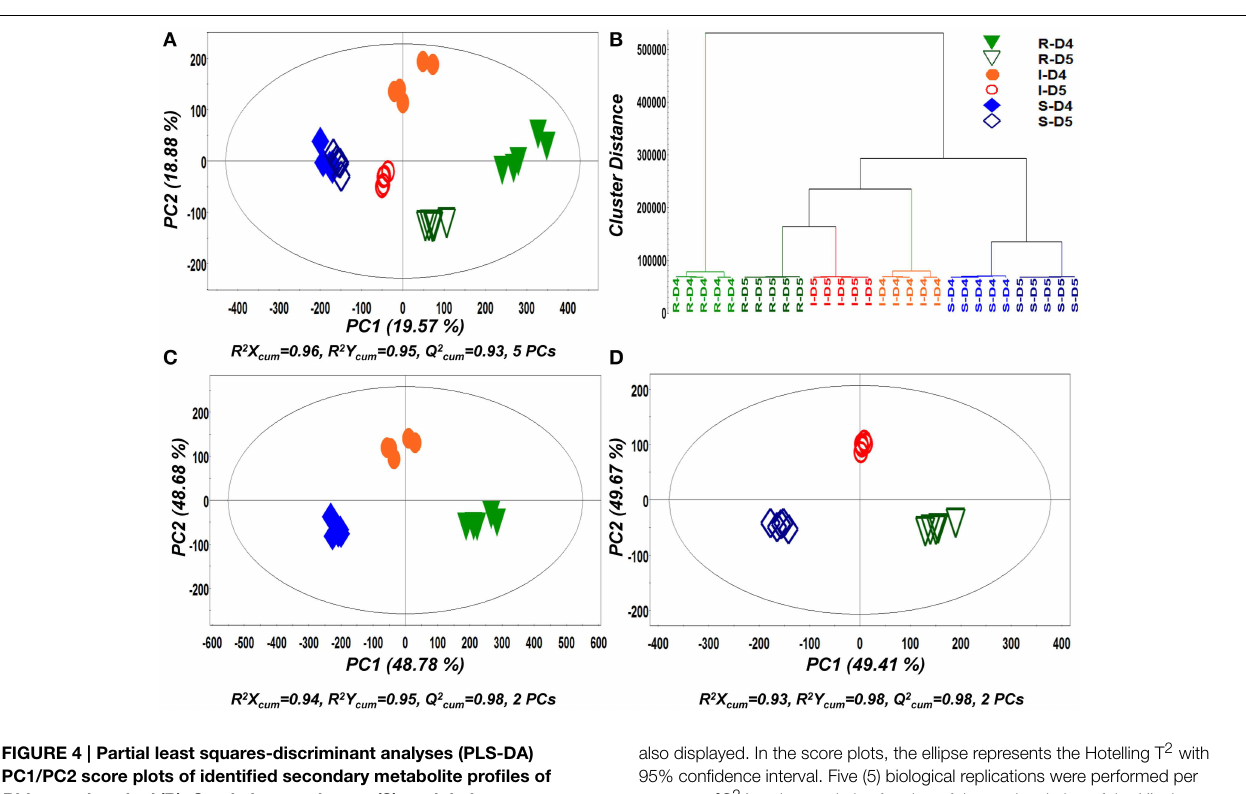
FIGURE 4 | Partial least squares-discriminant analyses (PLS-DA) PC1/PC2 score plots of identified secondary metabolite profiles of Rhizoctonia solani (R), Stachybotrys elegans (S), and their dual-cultures (I), 4 (D4) and 5 (D5) days following inoculation (A) and corresponding PLS-dendrogram perfoming hierarchical cluster analysis (HCA) (B). PLS-DA PC1/PC2 score plots for D4 (C) and D5 (D) are